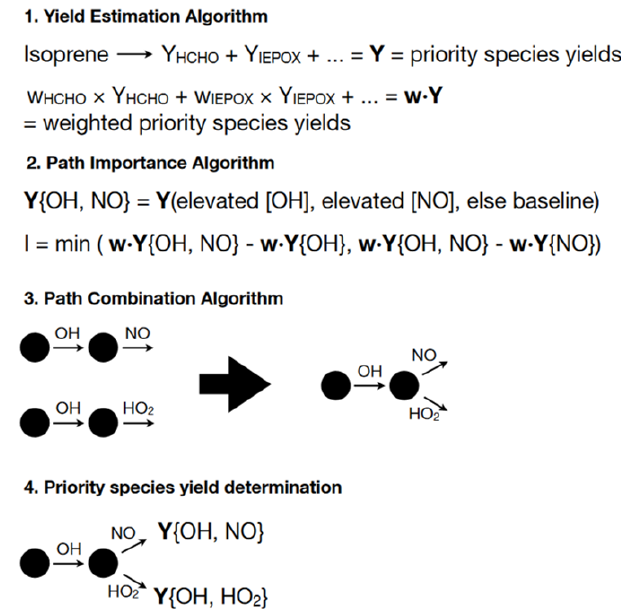
Figure 1. Schematic of the AMORE algorithm. The sub-algorithms are shown in order of implementation. Brackets are used specify a pathway within the mechanism, with each oxidant or nitrogen oxide within the brackets representing a reaction in a sequence involving that oxidant. For example, the pathway {OH, NO} represents a se- quence of two reactions joined by an intermediate, in which OH and NO are reactants in the two reactions. The pathway {OH, NO} is shown as an example for sub-algorithms